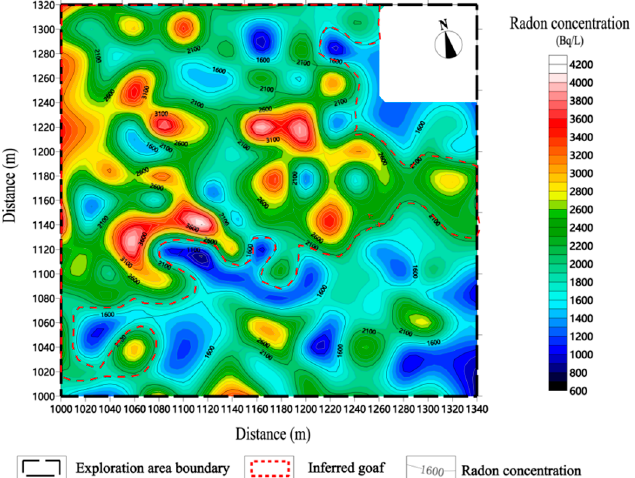
Figure 14. Contour Line Plane of Radon Values Measured by Activated Carbon and Goaf Anomaly Interpretation (Red Wireframe) Map.